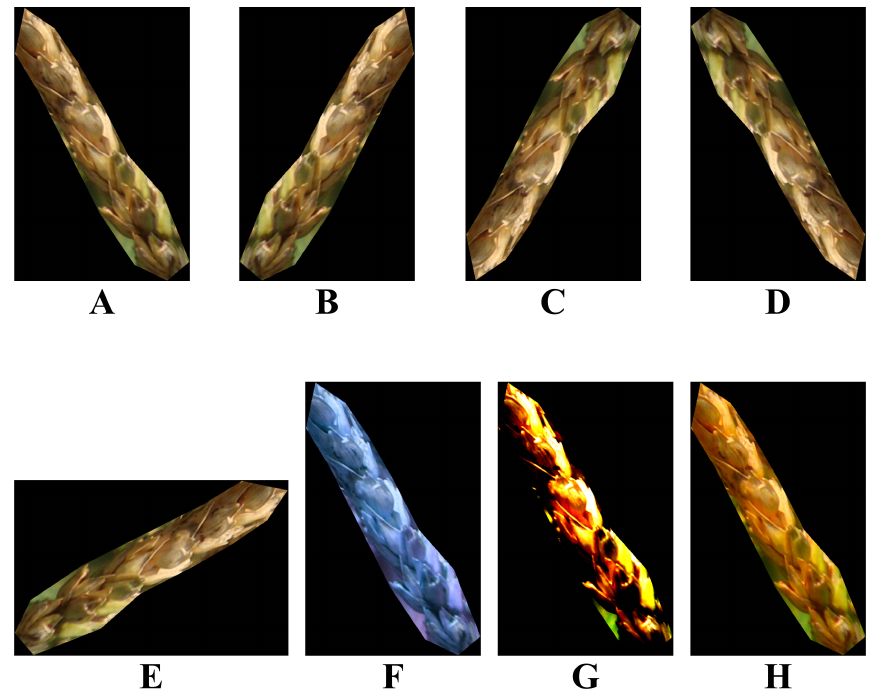
Figure 7. Illustration of different enhancement methods. ( A ) Original image. ( B ) Vertical flipping. ( C ) Horizontal flipping. ( D ) Horizontal and Vertical flipping. ( E ) Rotation of 90 degrees. ( F ) Hue adjustment. ( G ) Contrast adjustment. ( H ) Saturation